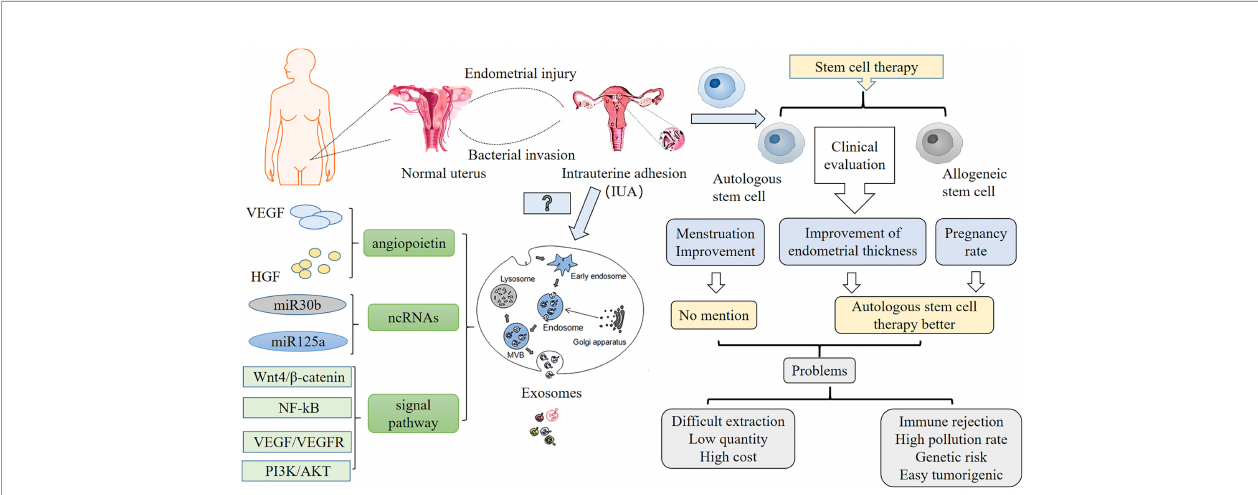
FIGURE 11 | Summary of the current clinical ef fi cacy evaluations of and existing problems with autologous and allogeneic stem cells for the treatment of intrauterine adhesions (IUAs). The results show that from the perspective of endometrial thickness improvements and pregnancy rates, autologous stem cell treatment is superior to allogeneic stem cell treatment, but both have drawbacks. Therefore, whether exosomes with lower immunogenicity can be used for the treatment of IUA in the future, to solve the problems of extraction dif fi culty, small numbers, and immune rejection, remains to be studied. Exosomes are extracellular vesicles released when MVBs fuse with the cell membrane or originate from cell membrane processes. Microbubbles germinate from the plasma membrane. Researchers have pointed out that exosomes mainly function through angiopoietins, such as VEGF and HGF; ncRNAs, including miR30b, miR125a; and various signaling pathways, like Wnt4/ bcatenin, NF-kB, VEGF/VEGFR, and PI3K/AKT, which can promote angiogenesis. However, whether exosomes can improve IUA through these means and the mechanism through which exosomes improve IUA have still not been experimentally proven, which requires further